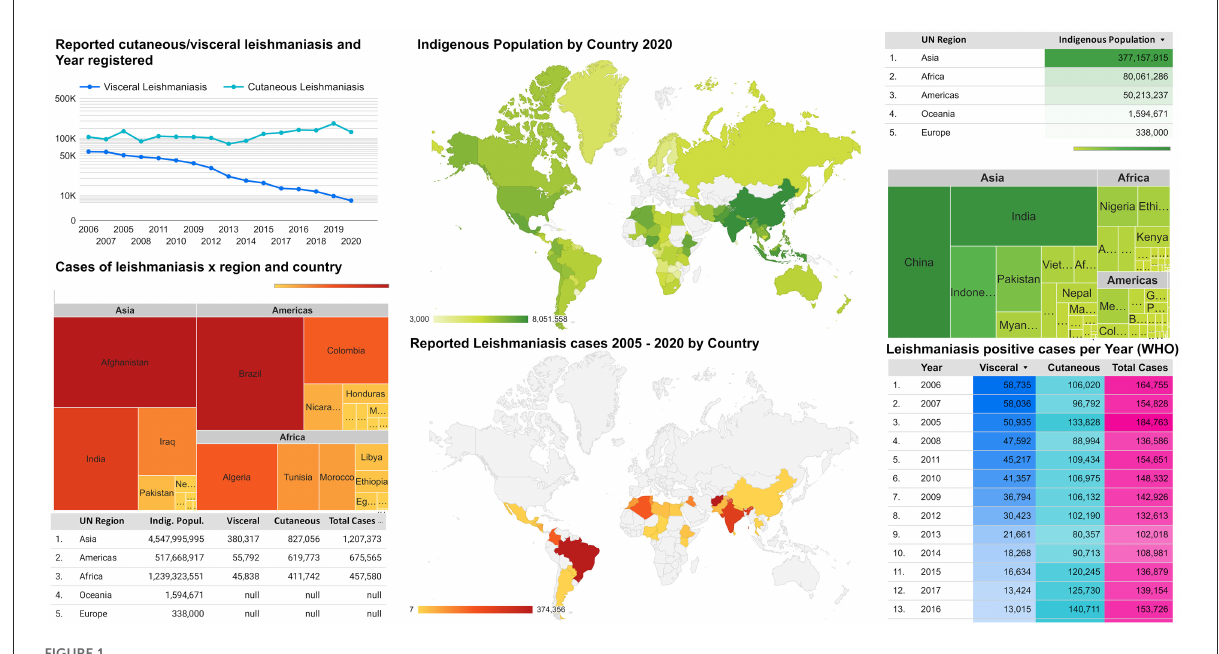
FIGURE1 Global distribution of leishmaniasis endemic areas and the average of indigenous populations.